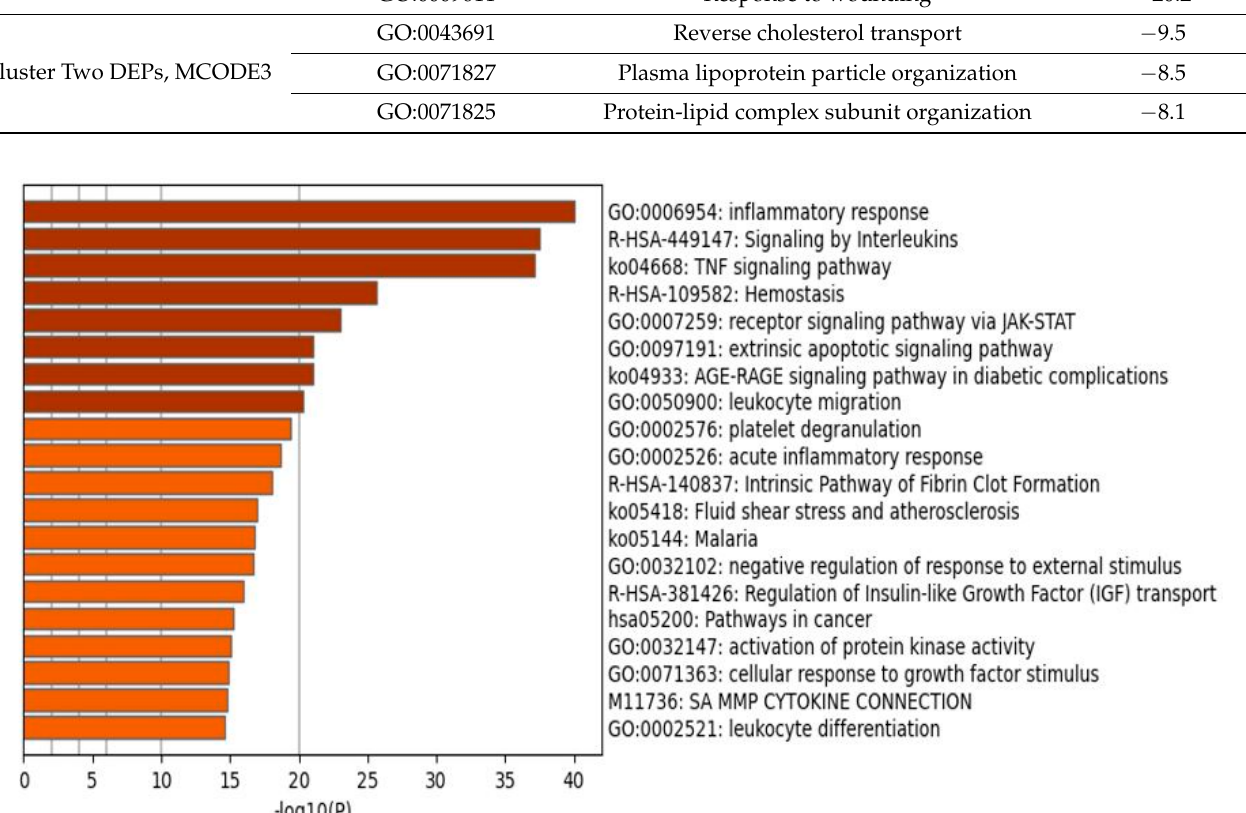
Figure 2. Heatmap of enriched terms showing the top 20 functions that were overexpressed in the network of patients who died due to ischemic stroke (accumulative hypergeometric p -values).